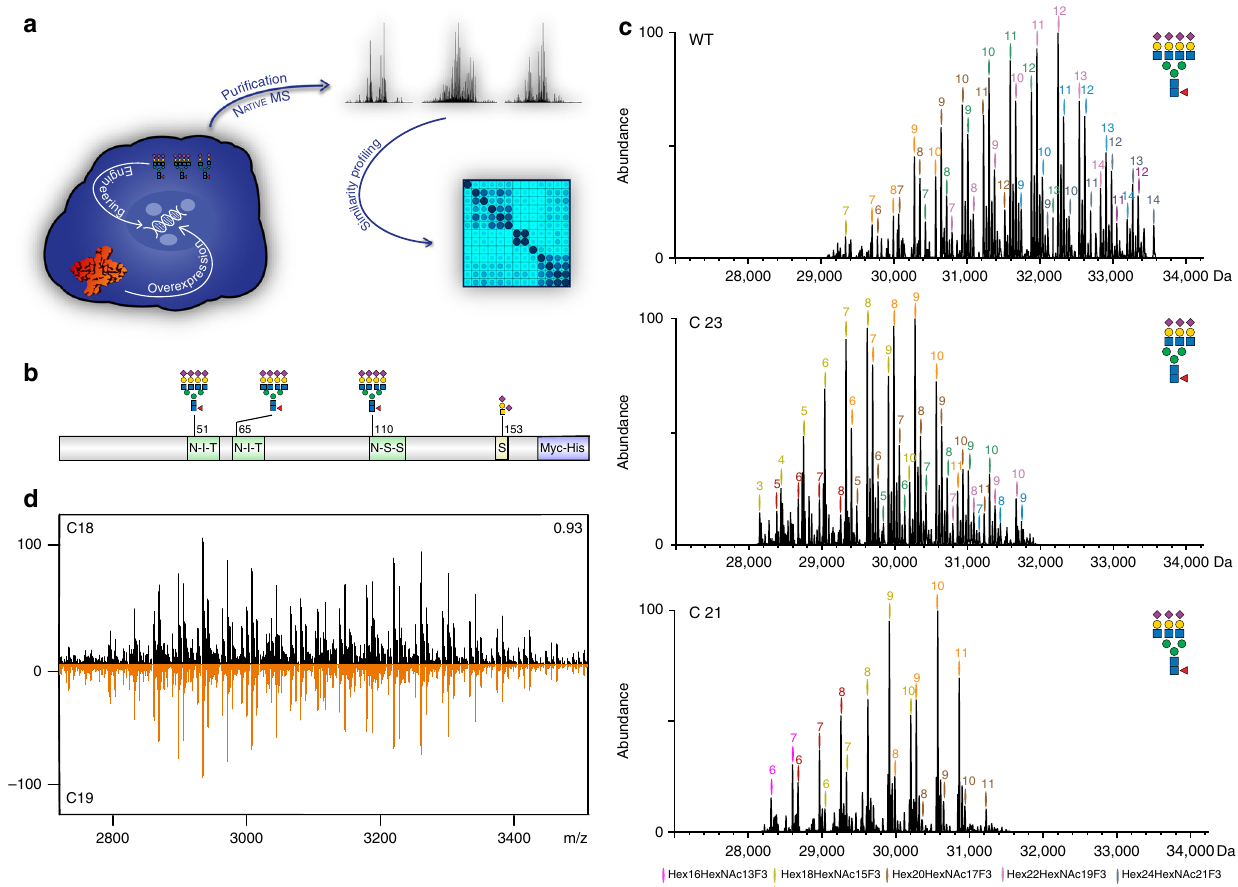
Fig. 1 Generation and structural assessment of wild type and glyco-engineered EPO. a Depiction of the work fl ow used in this study. EPO is overexpressed in CHO cells whereby speci fi c glyco-genes are manipulated to achieve the desired glycosylation, followed by EPO puri fi cation and native MS analysis. High- resolution native MS spectra of different clones are correlated, leading to a similarity matrix. b Depiction of EPO glycosylation sites. c Deconvoluted high- resolution native mass spectra of WT EPO (top) and two KO-based glyco-engineered clones: C23 (middle) and C21 (bottom). These two KO clones would supposedly delete β -4 and β -6branching of N -glycans as indicated by the pictograms. In these deconvoluted spectra the main glycoproteoforms are color coded, wherein each color corresponds to a unique Hex x + 3 HexNAc x F 3 composition, where F denotes fucose, and the numbers placed above the annotated peaks indicate the number of sialic acid residues. d Comparison of native mass spectra of EPO from two biological replicate clones C18 (black) and C19 (orange).The correlation coef fi cient between these two spectra over all ion signals is 0.93, as depicted in the top-right. All other high-resolution native mass spectra of EPO, puri fi ed from each of the prepared 25 clones, are provided in Supplementary Fig